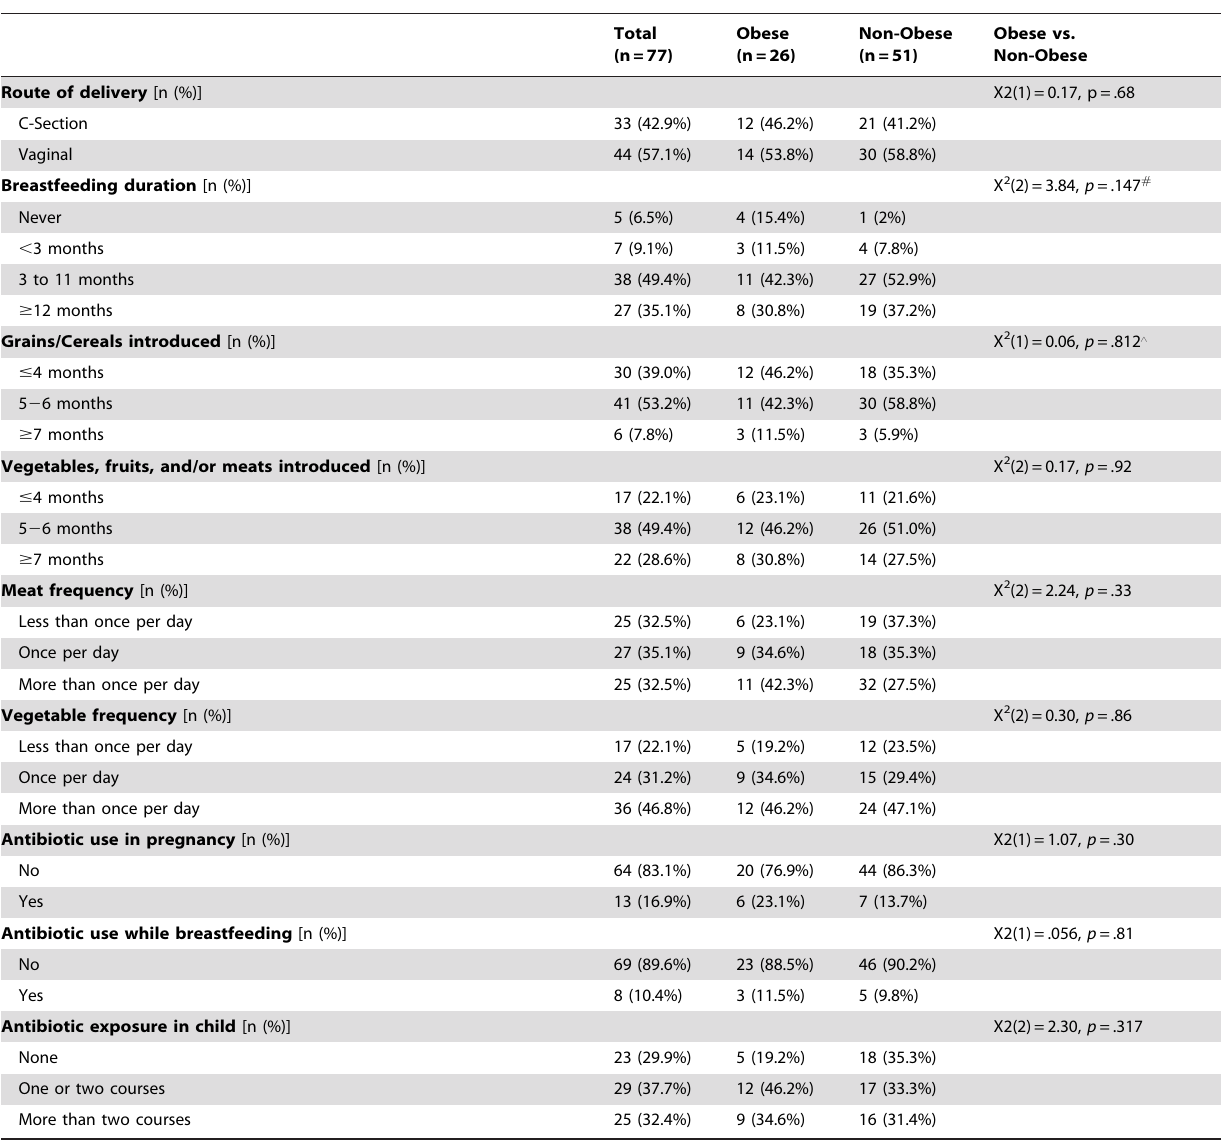
Table 2. Health/Behavioral